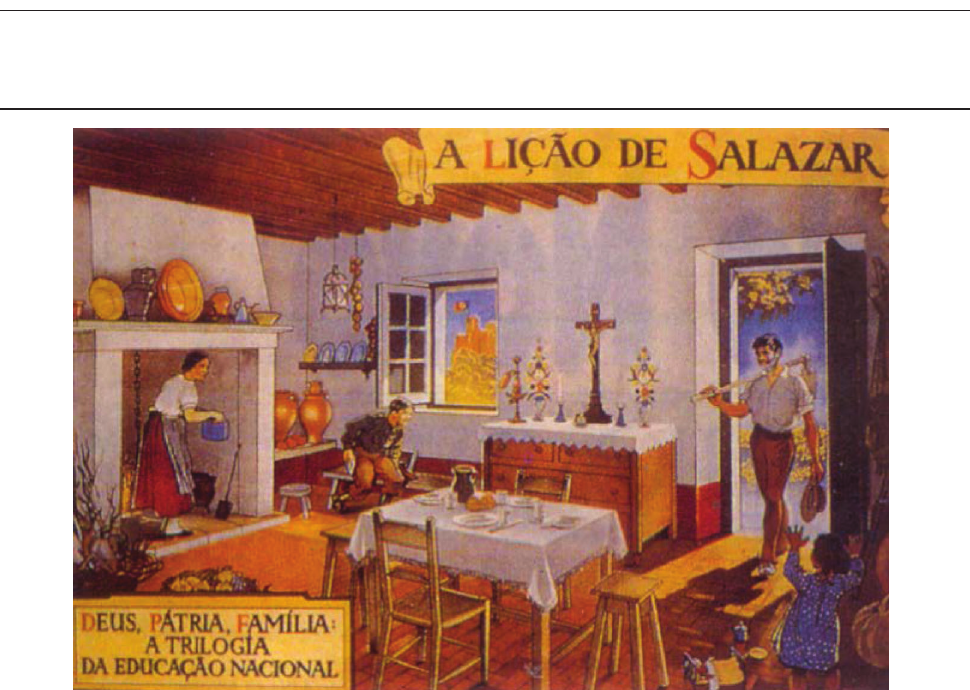
Picture E: Propaganda poster of the New State with a rural family (1938, A lição